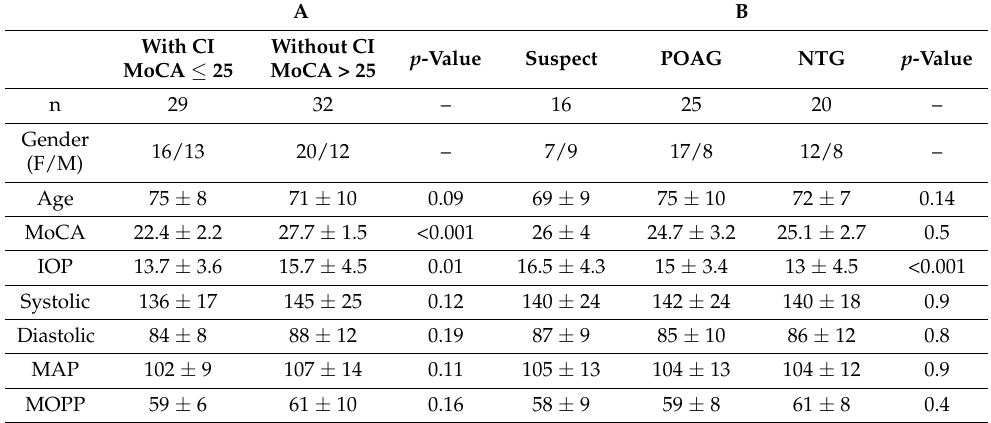
Table 1. Participant demographics. Assessed based on (A) MoCA scores and (B) glaucoma subtypes.